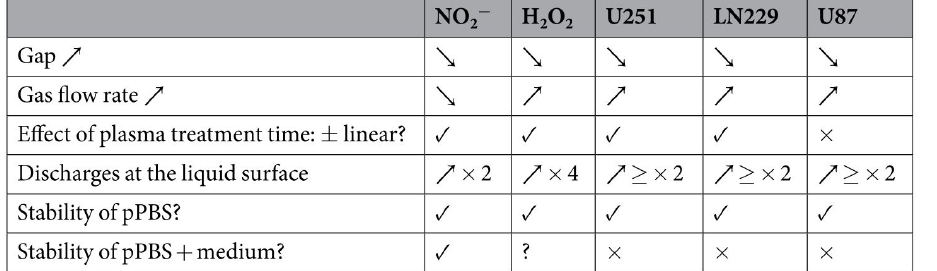
Figure 12. The effect of the gap, gas flow rate, plasma treatment time, the occurrence of discharges at the liquid surface, and the stability of a PTS (PBS, kINPen argon plasma jet) on the concentra- tions of NO 2- and H 2 O 2 in PTS and on the anticancer capacity of PTSs for three different cancer cell lines. Reproduced from [85] . Copyright 2017 Springer Nature.